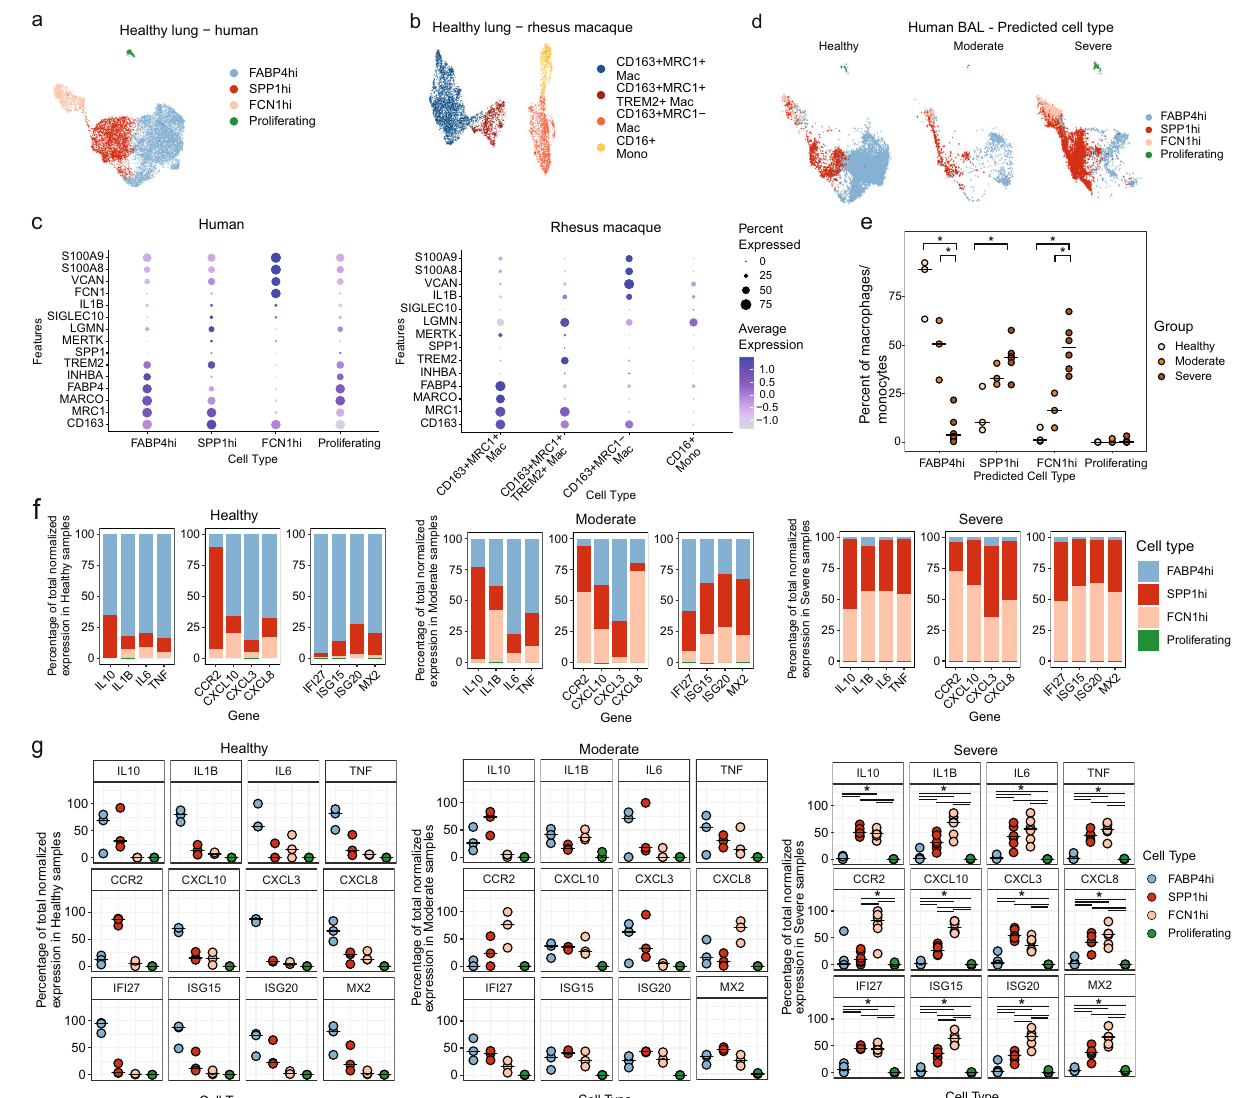
Fig. 4 | Comparison of rhesus and human macrophage subsets. a UMAP ofmacrophagesubsetsinlungsfromsixhealthyhumandonors(GEO:GSE135893). b UMAP of macrophage subsets in lungs from three healthy rhesus macaques (GEO: GSE149758). c DotPlots showing the expression of marker genes. The color gradient represents the level of expression and the size of the dot represents the percentage of cells expressing a given gene. d UMAP of BAL samples from human donorsthatarehealthy ( n =3),orsuffering frommoderate ( n =3)or severe( n =6) COVID-19 (GEO: GSE145926) mapped to the healthy lung reference using the SeuratMapQueryfunction. e Percentofpredictedcelltypesoutofallmacrophage/ monocytes in each human BAL sample. The black bar indicates the median. Sta- tisticalanalysiswasperformedusingpairwisetwo-tailedMann – Whitney U testinR